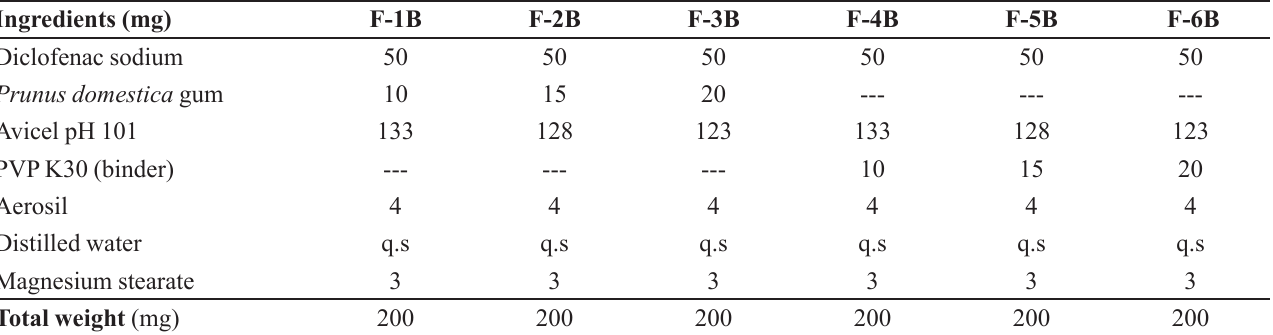
TABLE I – Formulation of different batches of sodium diclofenac tablets Ingredients (mg) Diclofenac sodium